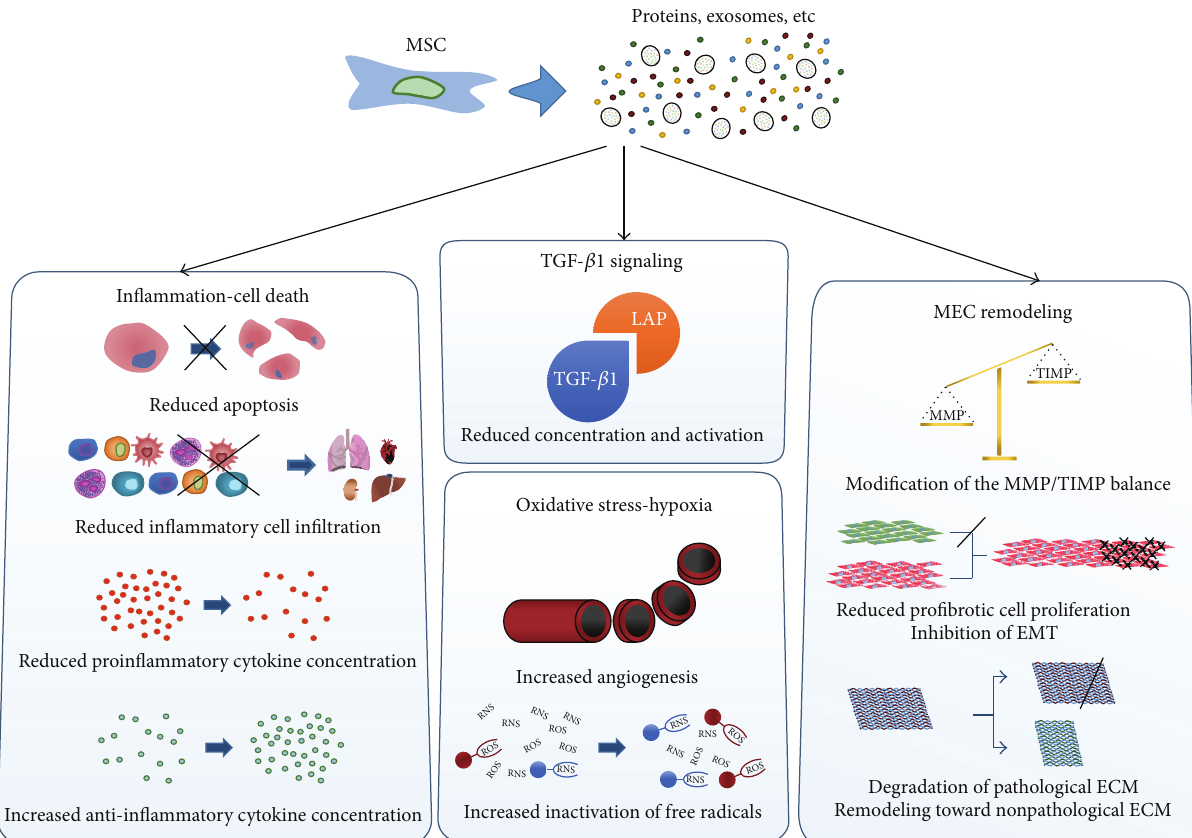
Figure 4: Common outcome of MSC therapy for various fibrotic diseases. Based on the studies reported in this work, several mechanisms havebeenunderlined,mostlyconcerninginflammatoryreactionandapoptosis,oxidativestress/hypoxiamodulation,andextracellularmatrix remodeling. It appears that MSC secretome activates a wide range of antifibrotic pathways (ECM: extracellular matrix, EMT: epithelial- to-mesenchymal transition, LAP: latency associated protein, MMP: matrix metalloproteinase, MSC: mesenchymal stromal cell, TGF- 𝛽 : transforming growth factor- 𝛽 , and TIMP: tissue inhibitor of